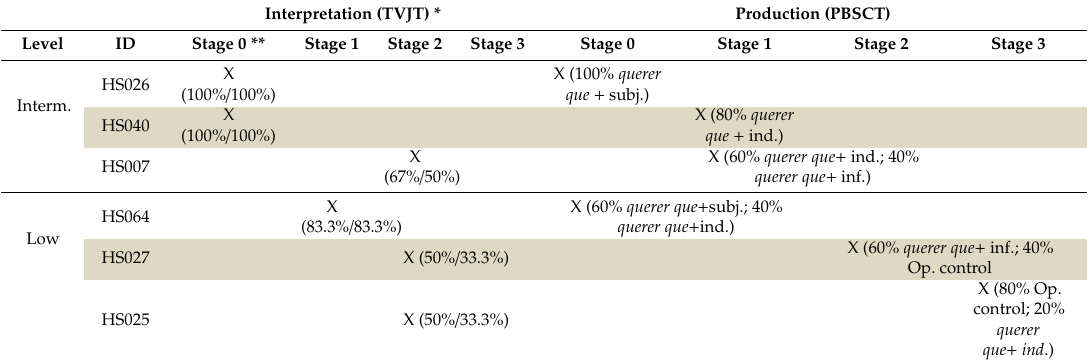
Table 4. Re-analysis of Perez-Cortes (2016) data following our model (Stage 4 not attested). Interpretation (TVJT) * Production